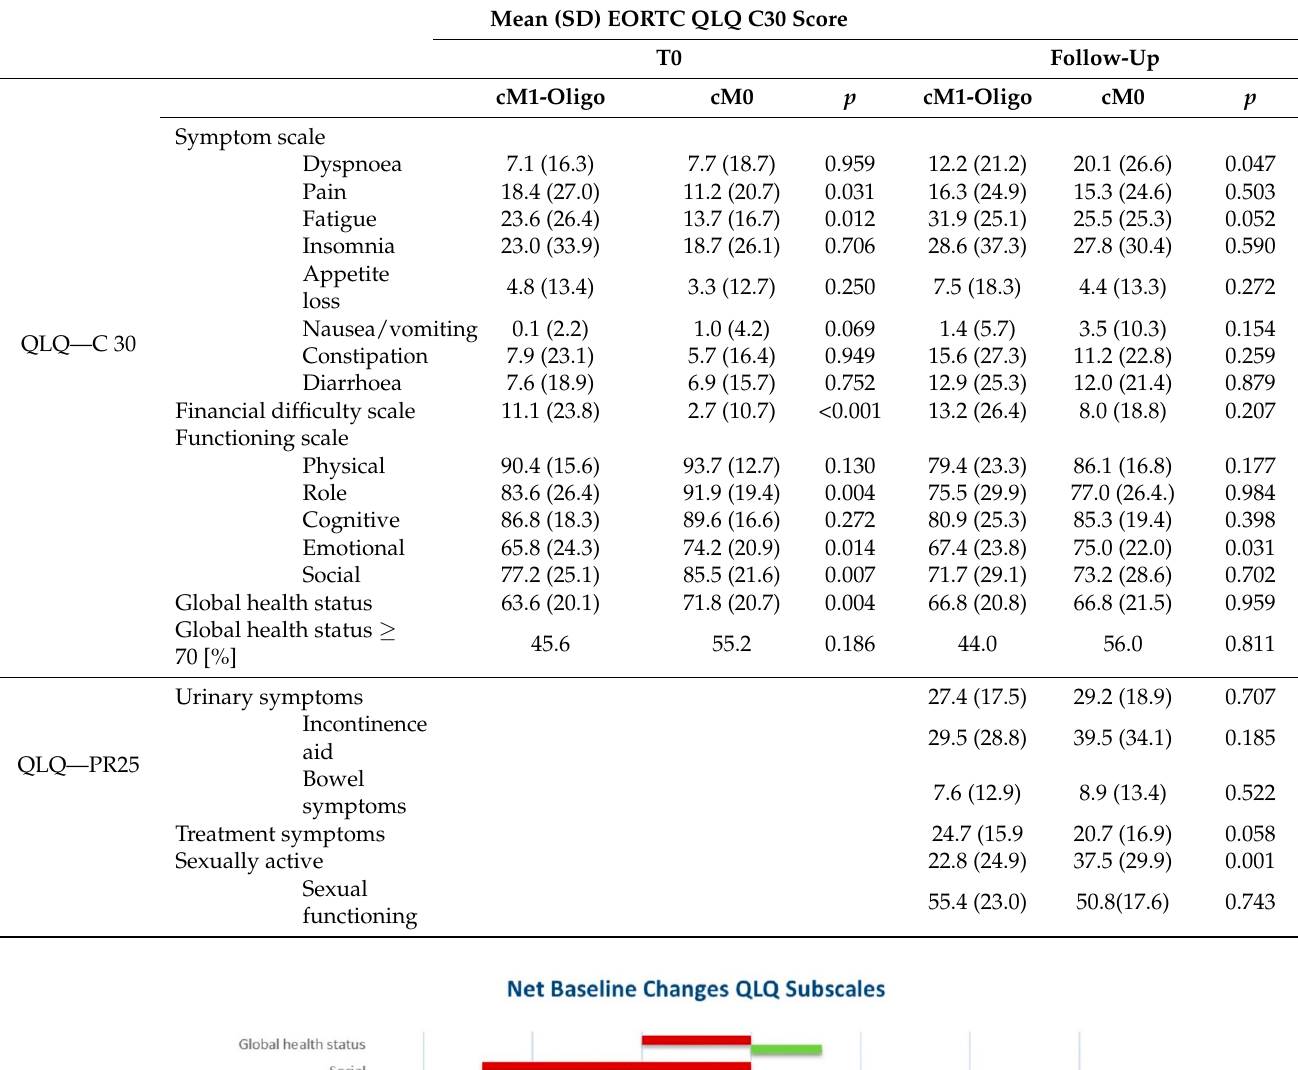
Table 3. Pre- and postoperative patient-reported HQOL, assessed by the validated EORTC QLQ-C30 questionnaire. Bold values indicate p -values < 0.05 and were considered statistically significant. Continuous values are presented as median and standard deviation (SD). HRQOL : health-related quality of life; EORTC-QLQ-C30: European Organization for Research and Treatment of Cancer quality of life questionnaire-Cancer 30; QLQ-PR25: European Organization for Research and Treatment of Cancer quality of life questionnaire-Prostate 25.